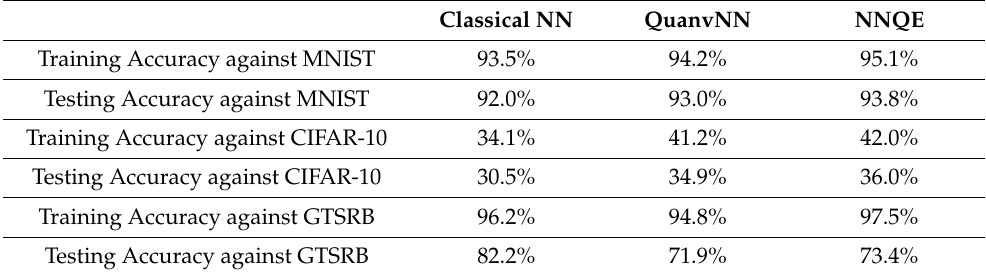
Table 2. Converged training and testing accuracy.